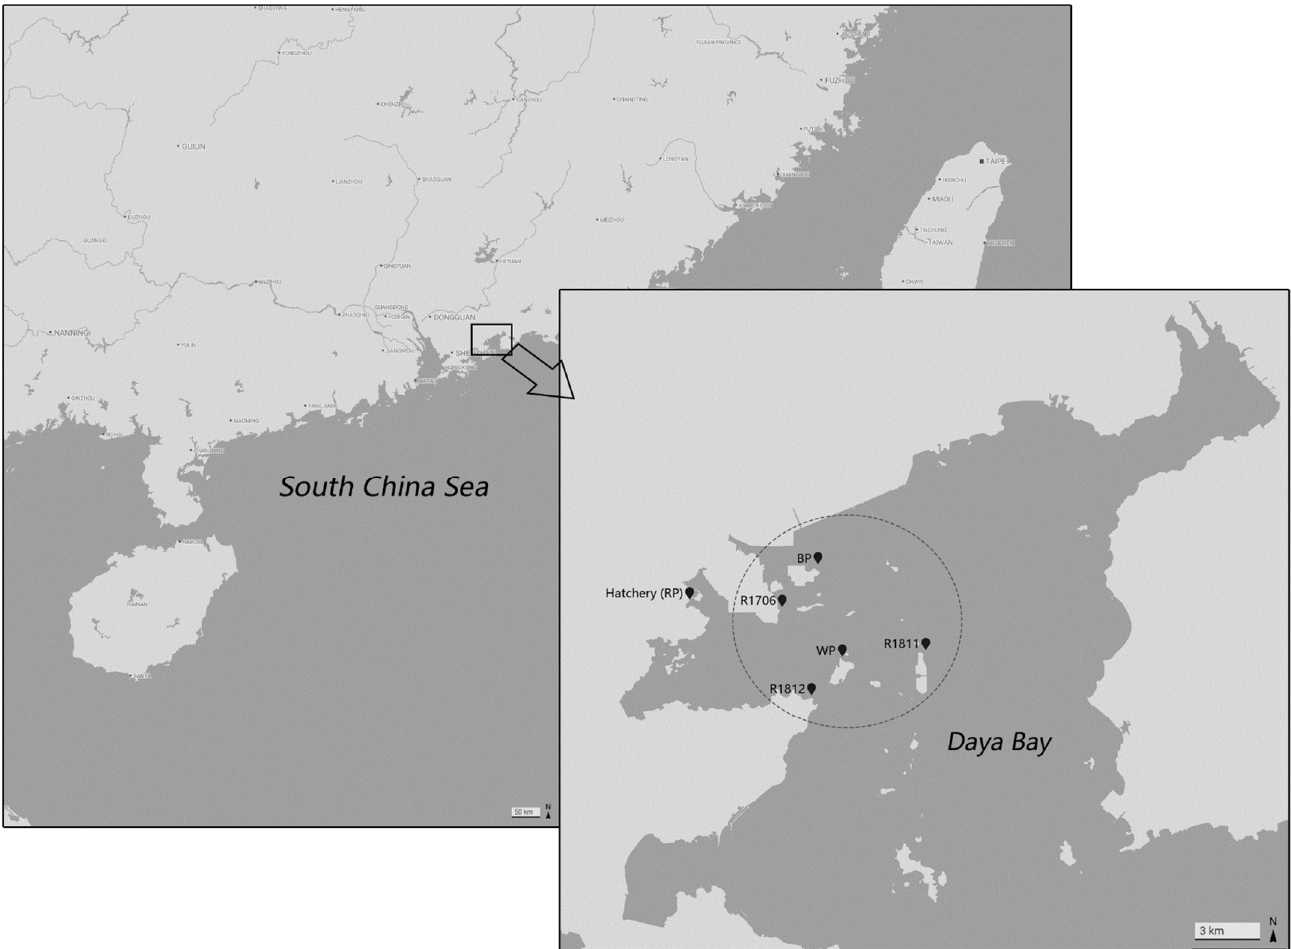
Figure 1. Sampling location (created with Datawrapper). Dashed circle is the area where a majority of wild black sea breams inhabit Daya Bay; BP, broodstock population; RP, released population; WP, wild population; R1706, R1811 and R1812 are three recaptured populations of black sea